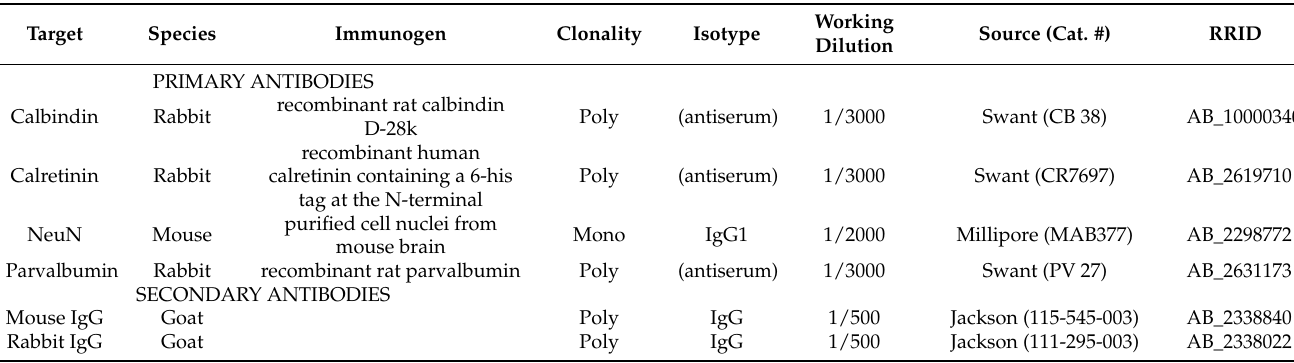
Table 1. Table of